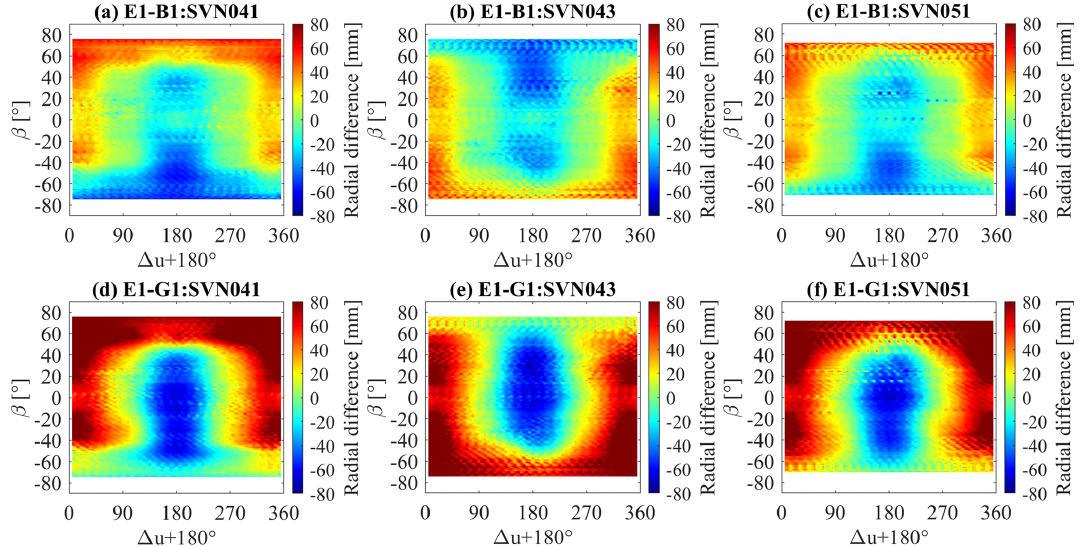
Figure 5. Radial orbit comparison of ECOM1 and GSPM1/BOXW1 for SVN041 (a, d) , SVN043 (b, e) and SVN051 (c, f) .